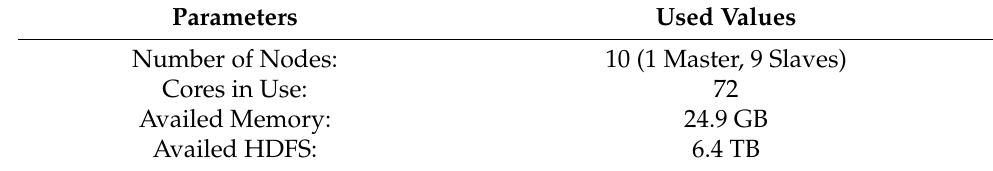
Table 2. HPDA Cluster Specifications.